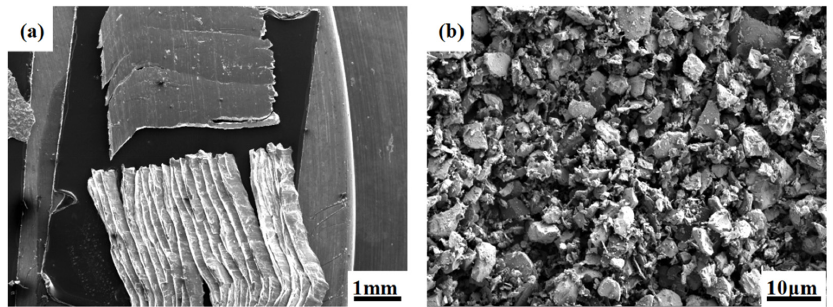
Figure 1. The morphology of initial materials: ( a ) AZ31 Mg alloy chips and ( b ) TiB 2 particles.